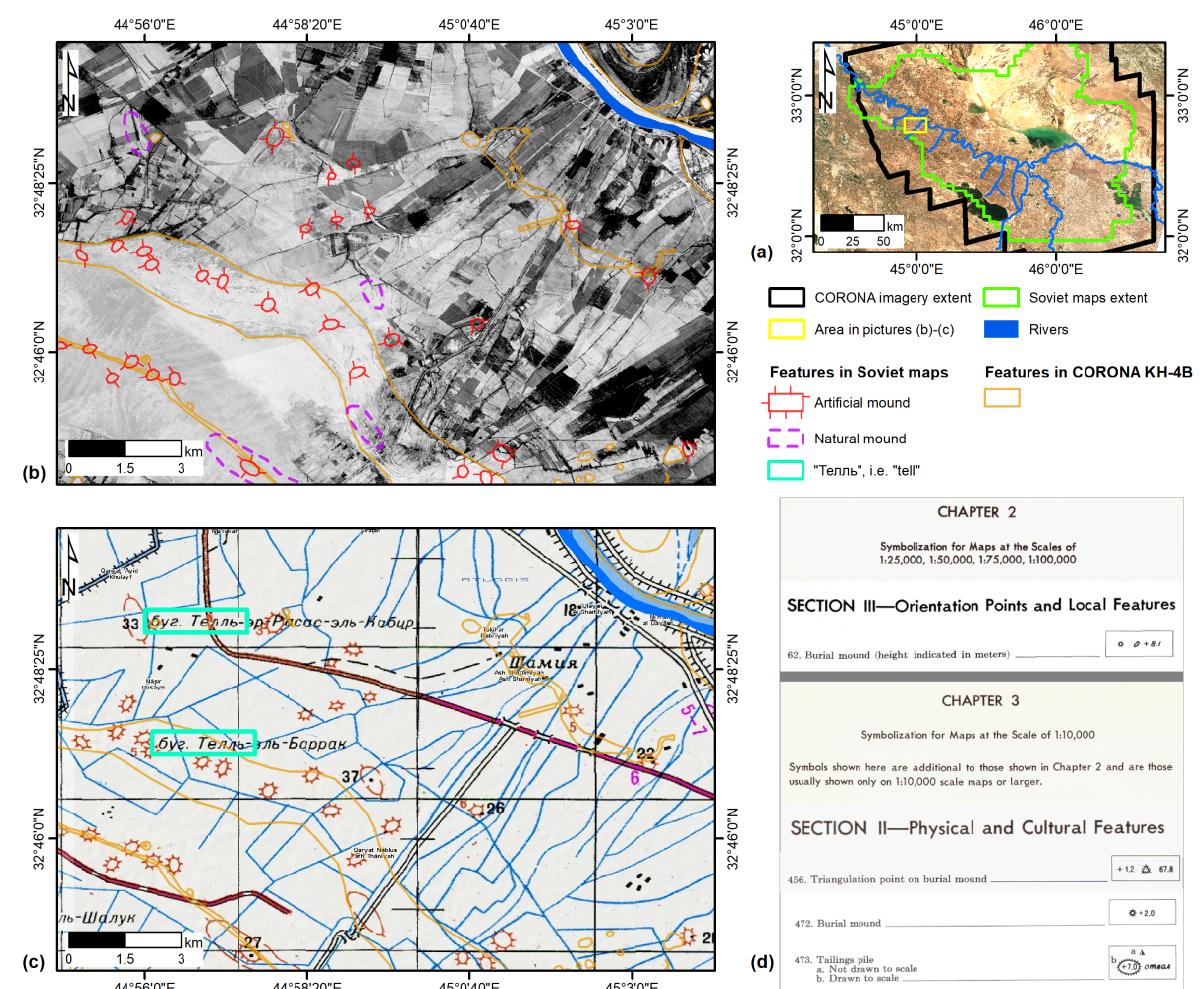
Figure 2. ( a ) Spatial extent and coverage of CORONA KH-4B tiles accessed from [61] and Soviet maps [66,67], overlapped onto 10 m resolution Copernicus Sentinel-2 data 2019. The yellow polygon indicates the location of the zoomed views in ( b , c ). ( b ) CORONA tile compared with ( c ) the Soviet map. Archaeological and natural features documented in these two historical cartographic and imagery sources are mapped and jointly displayed. ( d ) Excerpt of the Soviet topographic map symbols indicating “62. Burial mound (height indicated in meters)”, “456. Triangulation point on burial mound”, “472. Burial mound”, and “473. Tailings pile” from the map legend translated by the US Department of the Army (1958) [68]. The cyan polygons in picture ( c ) highlight surveyors’ annotation of tells.